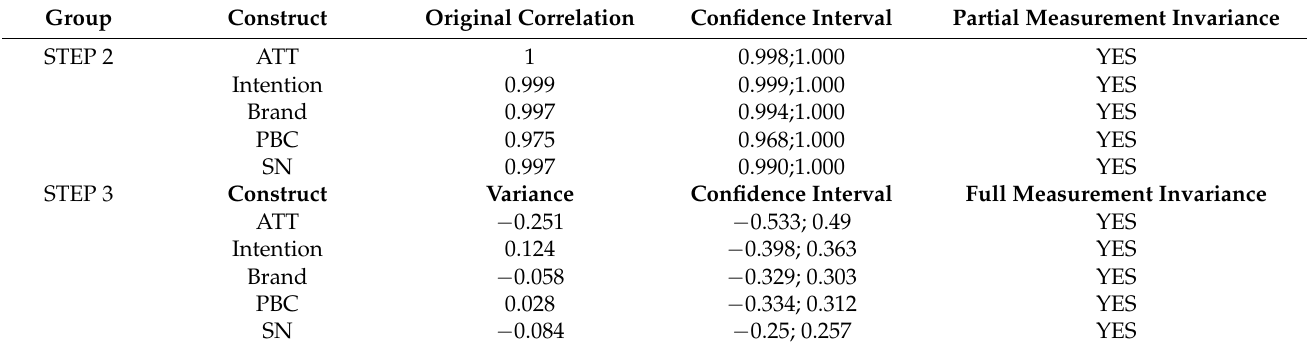
Table 4. The measurement invariance of composites (MICOM).